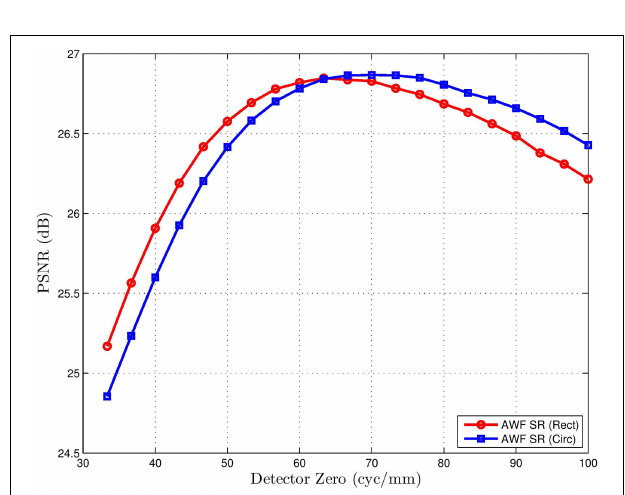
FIGURE 26 | PSNR for multiframe AWF SR for the 8 bit motocross image (kodim05.png) vs. the number of frames K . Shows is the result for a 100% fill factor detector, as well as 25% rectangular and 29.22% circular detectors with zeros at the optical cutoff frequency. Bicubic interpolation of a single frame is also shown for reference. Note that the reduced fill factor detectors benefit more from a larger K as this can help to compensate for the lower